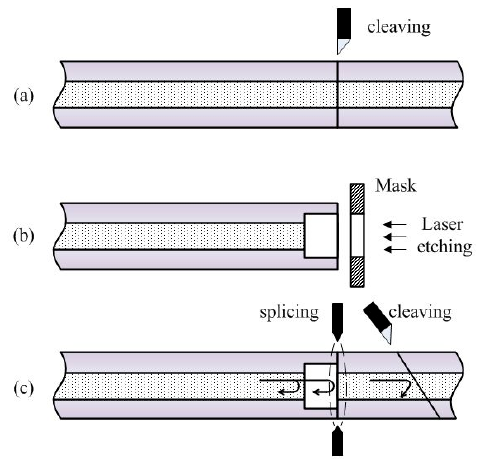
Figure 3. Fabrication process.